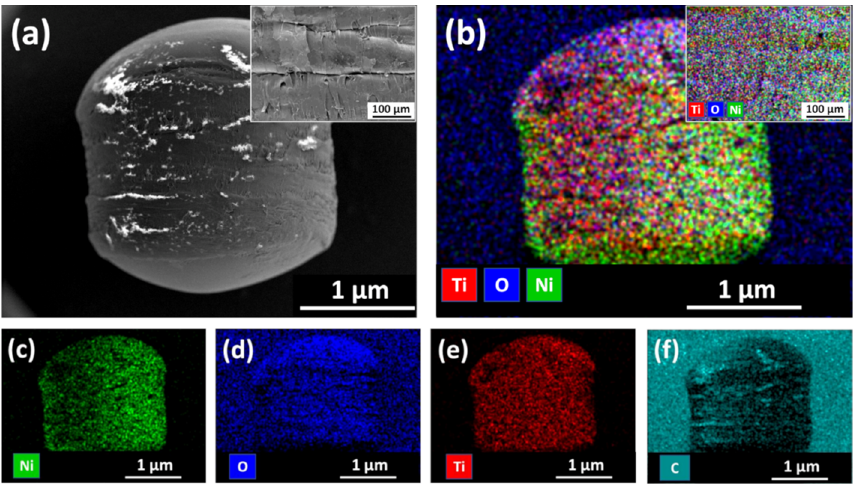
Figure 6. SEM image and EDS elemental mapping results of C-doped TiO 2 films with Ni underlayer deposited on HDPE beads: ( a ) surface morphology (insert—the central zone of the sample at higher magnification); ( b ) combined mapping of Ti, O, and Ni elements (insert—sample mapping at higher magnification); ( c ) Ni mapping results; ( d ) O mapping results; ( e ) Ti mapping results; ( f ) C mapping results.